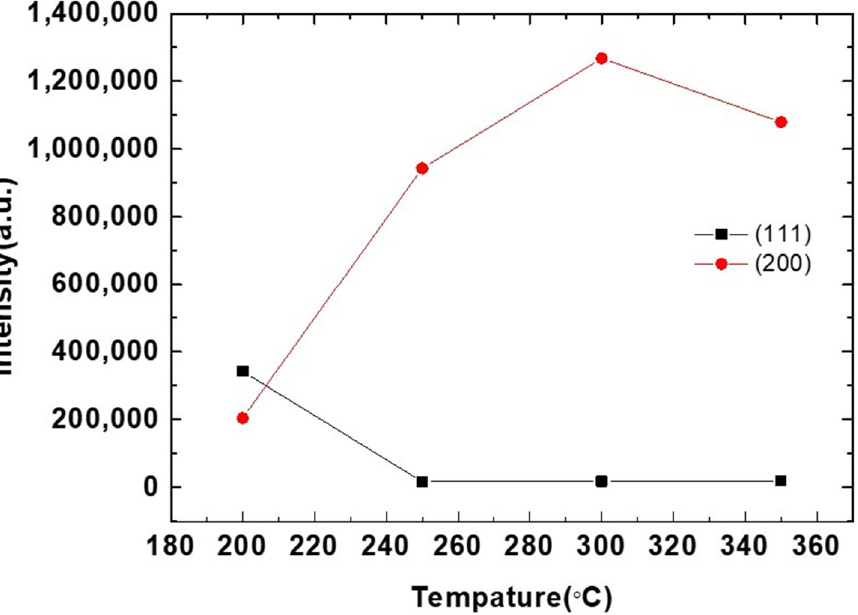
Figure 3. Comparison of (111) and (200) intensities with annealing temperature.